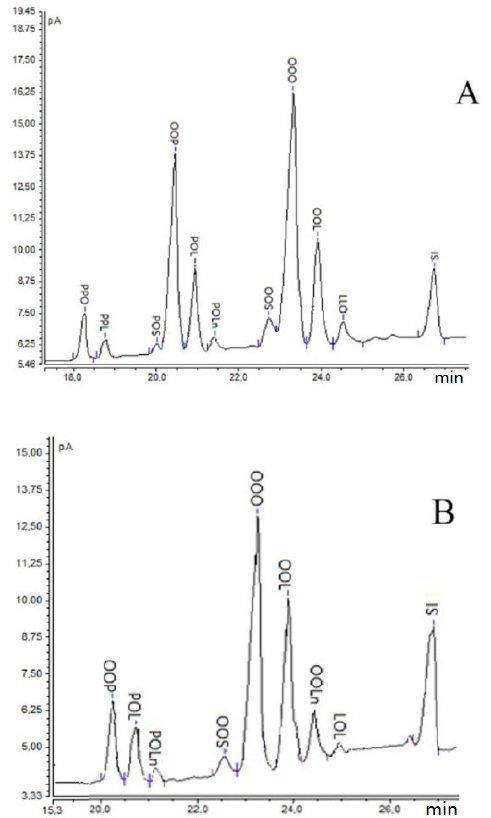
Figure 3. GC-FID chromatograms of TG in ( A ) olive oil (OO) and ( B ) refined rapeseed oil (RRO).